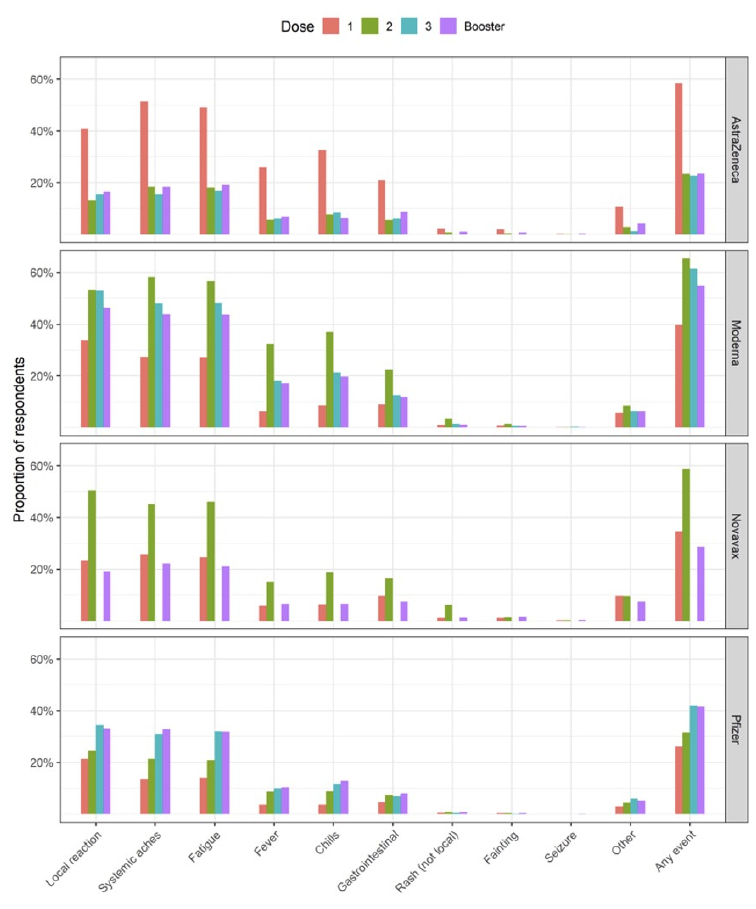
Figure 1. Proportion of individual adverse events (%) reported on day 3 following COVID-19 vaccination, stratified by vaccination brand and dose. Local reaction was defined as pain, redness, swelling, itching at or near the injection site. Systemic aches included headache, muscle/body aches, and joint aches/pain. Gastrointestinal included nausea, vomiting, diarrhoea, and/or abdominal pain. Six participants receiving Novavax as dose 3 responded to the day 3 survey, of which 0 events were